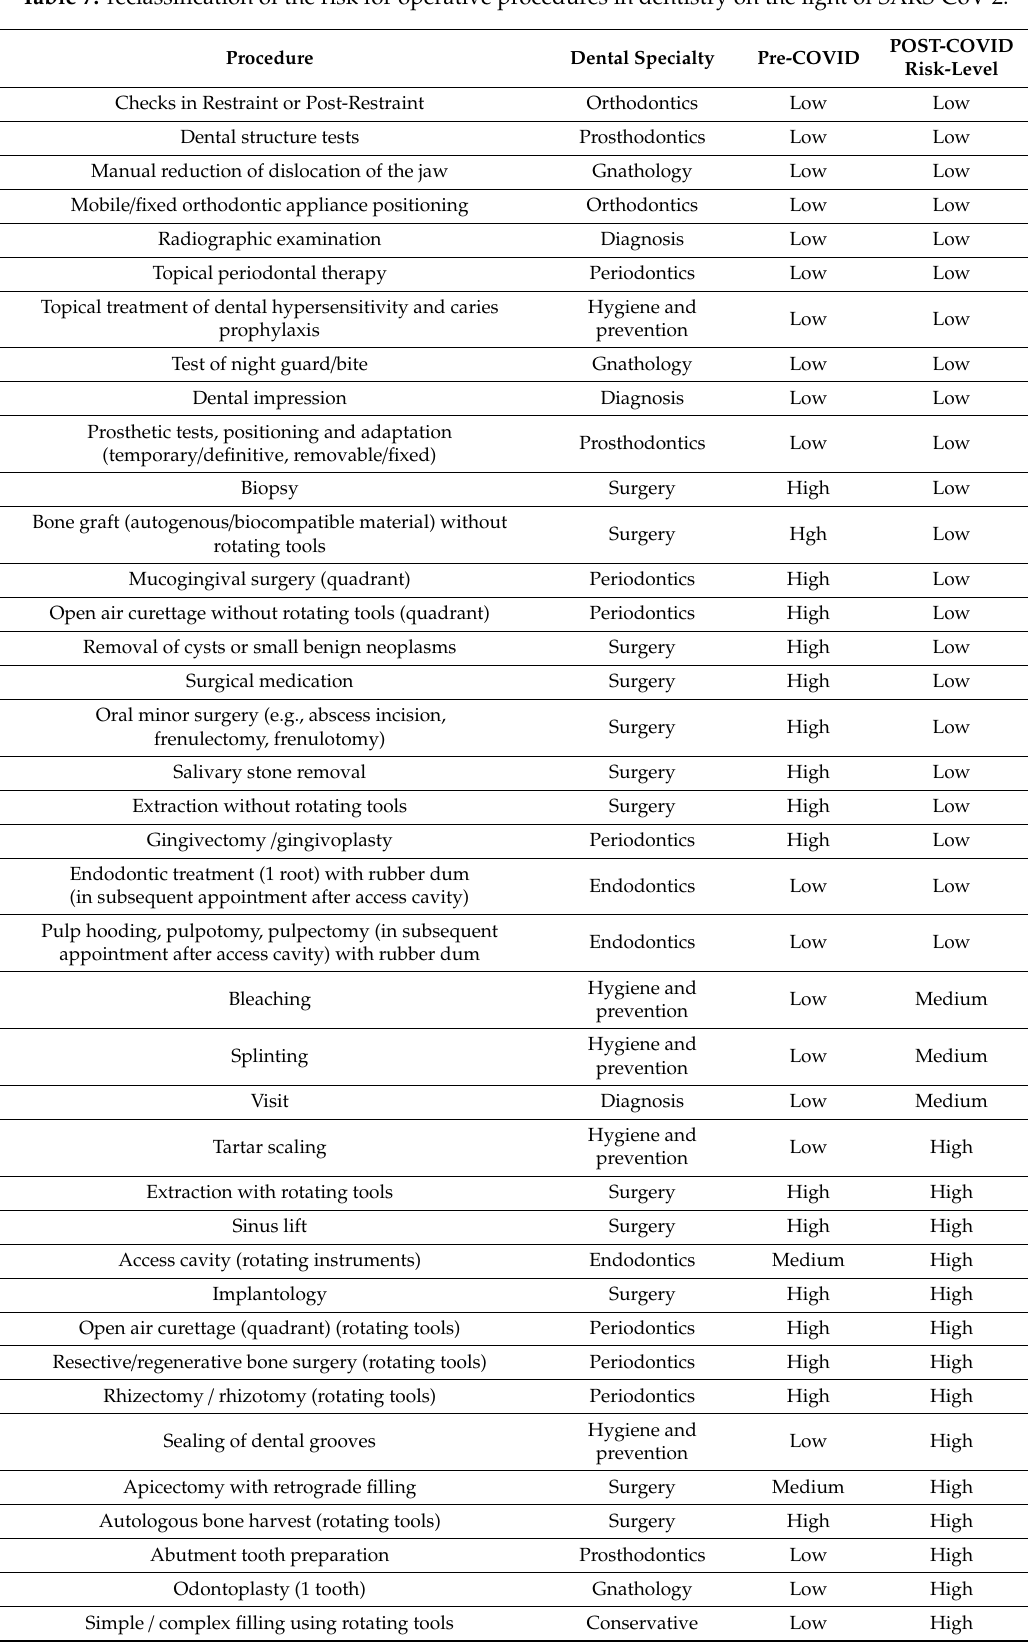
Table 7. reclassification of the risk for operative procedures in dentistry on the light of